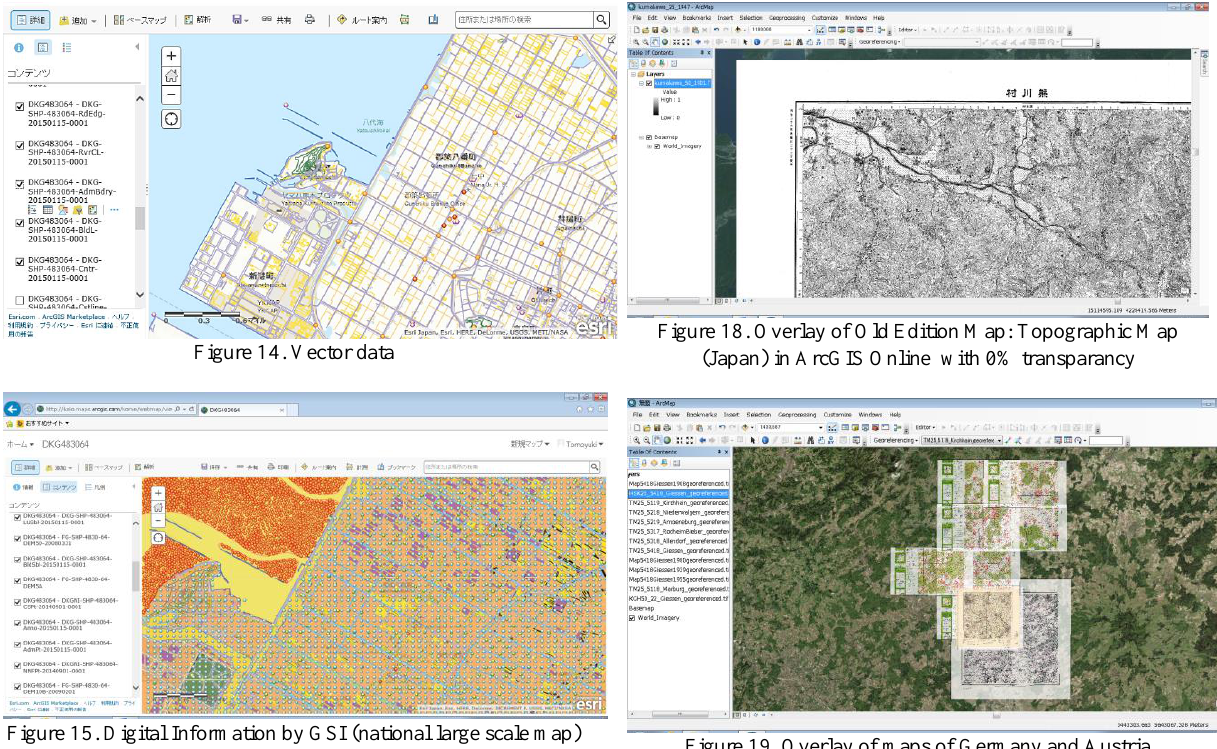
Figure 19. Overlay of maps of Germany and Austria